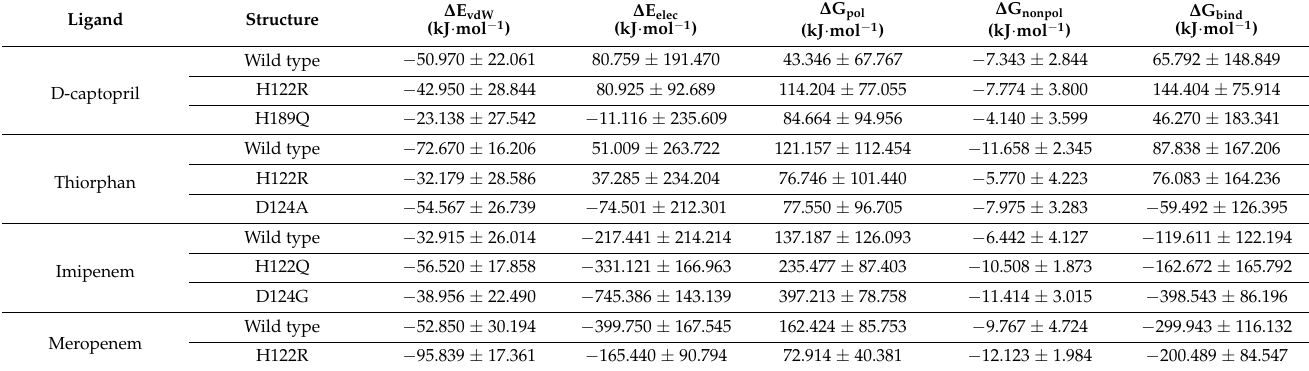
Table 4. The results of binding free energy of mutant and wild-type complexes with 4